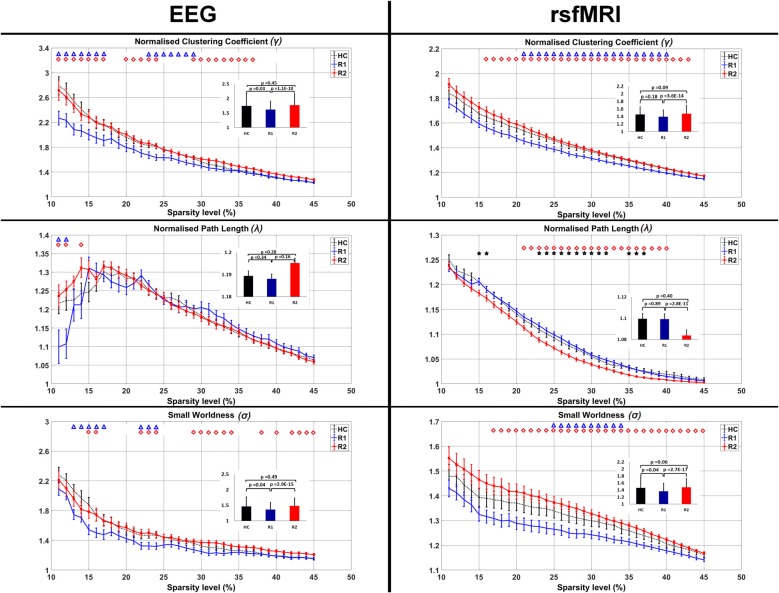
Comparison of the average clustering coefficient, pathlength and small-worldness in EEG and rsfMRI. The bar graph diagram in the inset shows the significance and the standard deviation. The blue triangle indicates the sparsity ranges that revealed significant differences between HC and R1, red quadrangle differences between R1 and R2 and black stars differences between HC and R2.